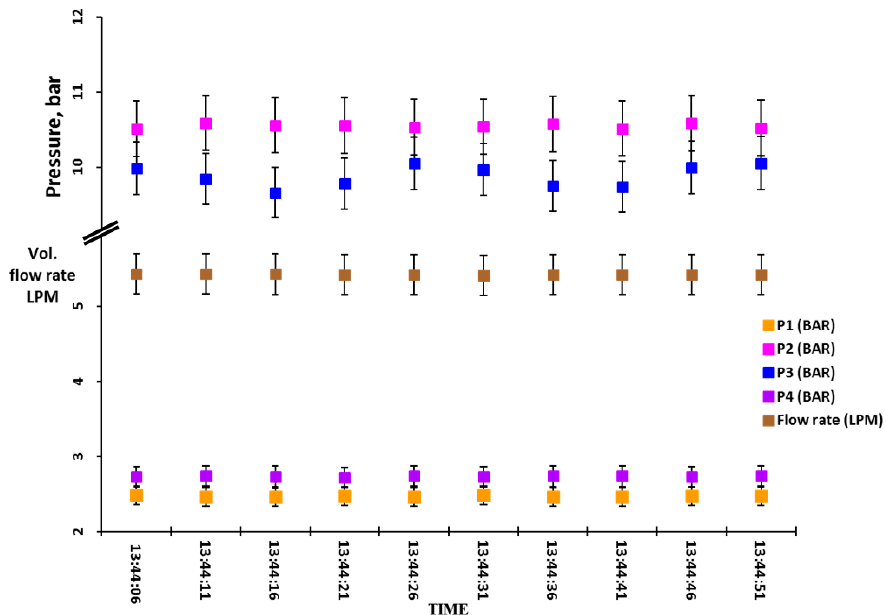
Figure 7. Pressure and volume flow rate data in steady state condition for R245fa 1:1 R123 working fluid, mass flow rate 0.125 kg/s and heat source 120 ° C with error bar 5%.